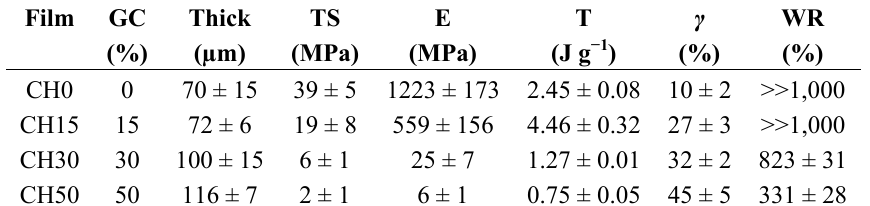
Table 1. Properties of films prepared using chitosan (CH) and glycerine. Glycerine content by weight relative to chitosan (GC), thickness (thick), tensile strength (TS), Young’s modulus (E), toughness (T), strain-at-break ( γ ) and water resistance (WR) for the different CH materials. All films were prepared using chitosan batch CHM1.